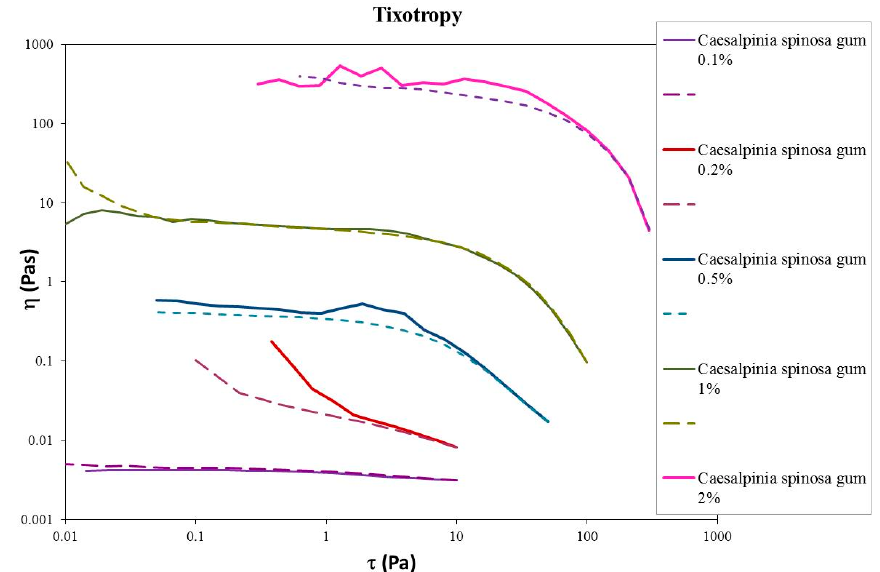
Figure 4. Caesalpinia spinosa gum thixotropy at several concentrations (0.1%, 0.2% 0.5%, 1%, 2%). Dotted lines refer to the return path.